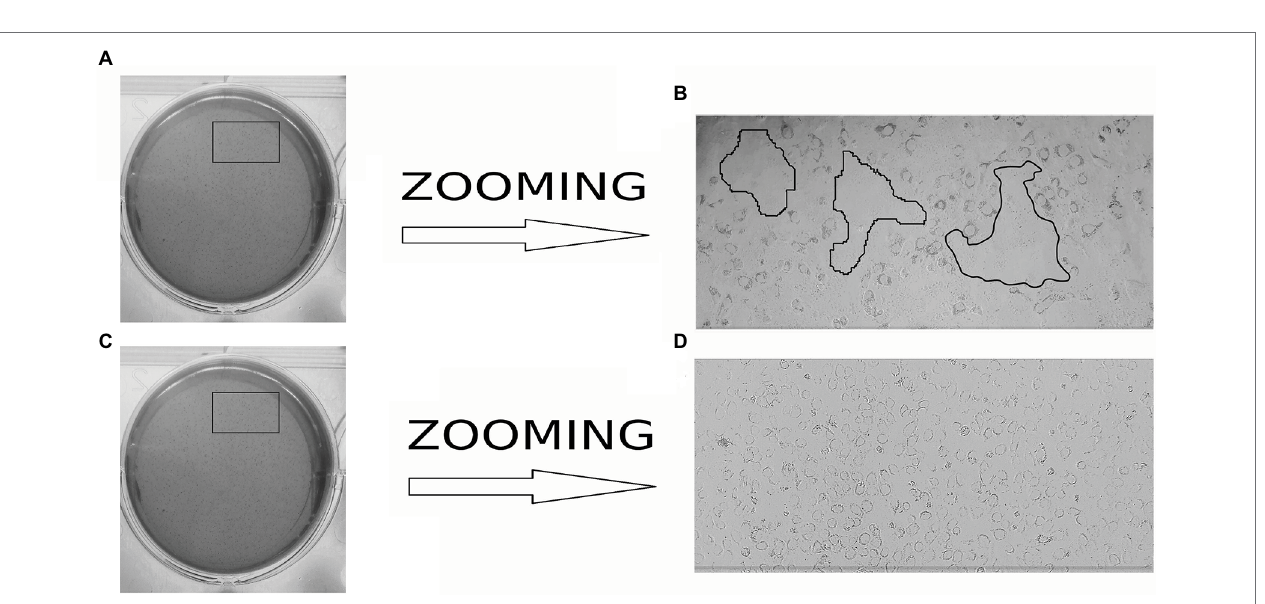
FIGURE 5 | Microscopy of Listeria monocytogenes in a monolayer of sheep kidney epithelial cells. (A) Infected monolayers of shKEC cells on a six-well plate. (B) The enlarged image area marked in a black frame in (A) is the lysis of eukaryotic cells infected with L. monocytogenes EGDe in a monolayer of shKEC cells for 7 days on a six-well plate. (C) Noninfected monolayers of shKEC cells on a six-well plate. (D) The enlarged image area marked with areas in a black frame in (C) is a monolayer of uninfected cells used as a